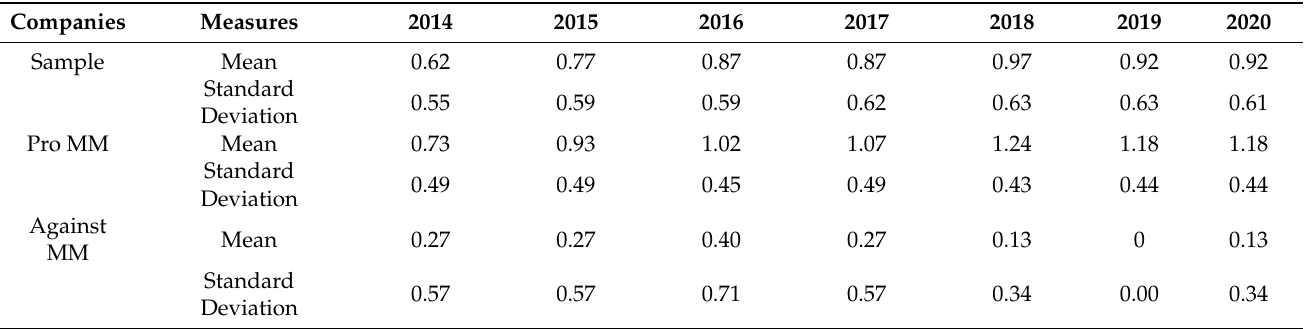
Table 7. Materiality matrices published over the period 2014–2020: descriptive statistics